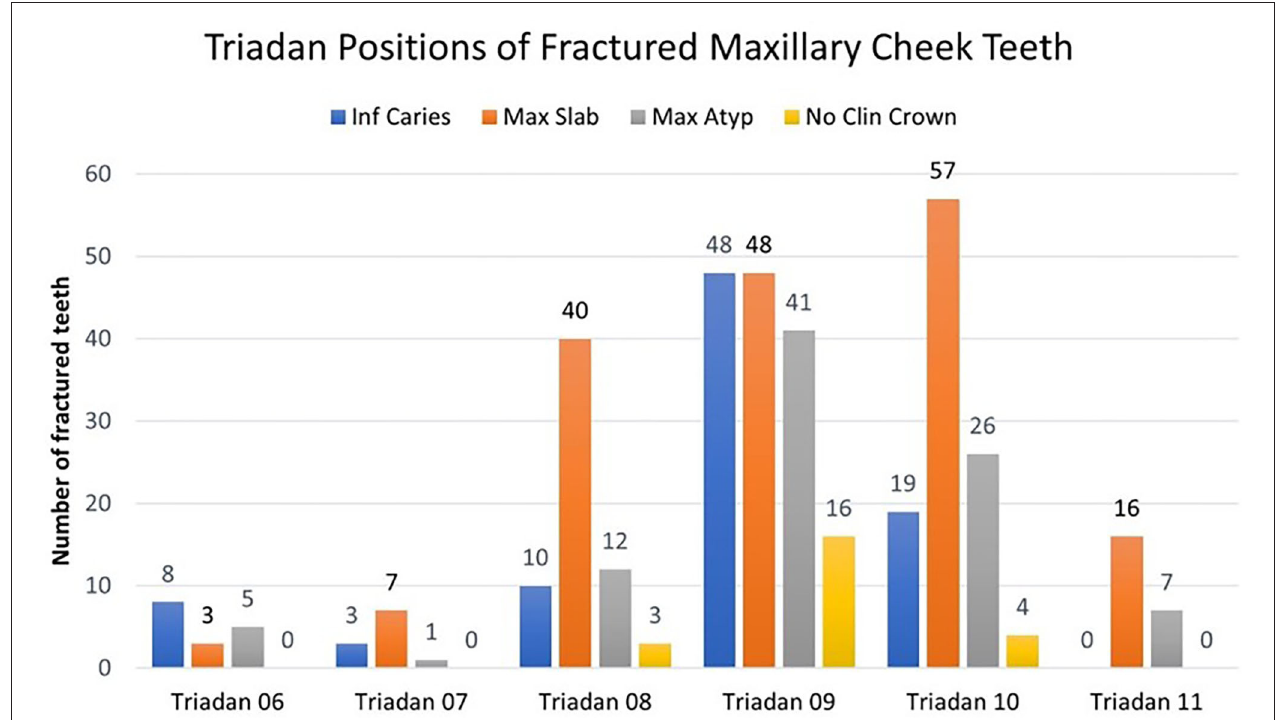
FIGURE 6 | Triadan positions of 374 fractured maxillary cheek teeth with four different fracture patterns according to Triadan positions. Inf Caries, infundibular caries-related fracture; Max Slab, maxillary first and second pulp horn fractures; Max Atyp, atypical maxillary cheek teeth fracture patterns; No Clin Crown, fracture with the absence of clinical